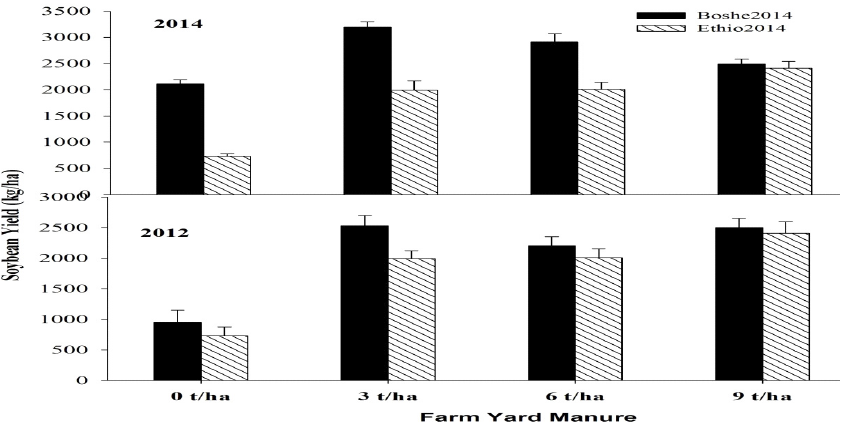
Figure 3. Effect of FYM application rates on yield of soybean varieties in the 2012 and 2014 cropping seasons at Bako, Ethiopia.